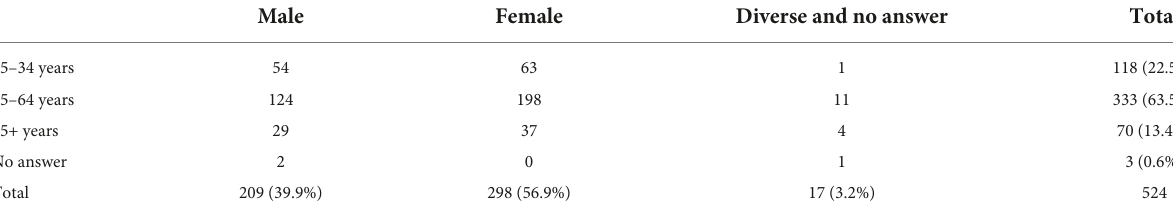
TABLE 1 Gender and age distribution of sample